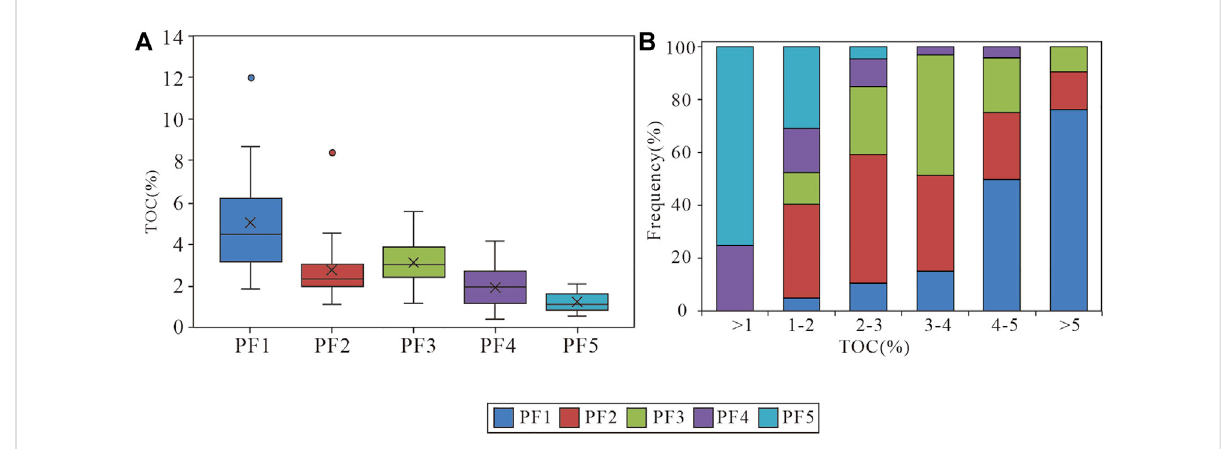
FIGURE 8 Relationship between thepalynofaciesandTOCofmudrocks. (A) .TOCvalues ofeachpalynofacies; (B) .palynofaciescompositionineachTOC interval.